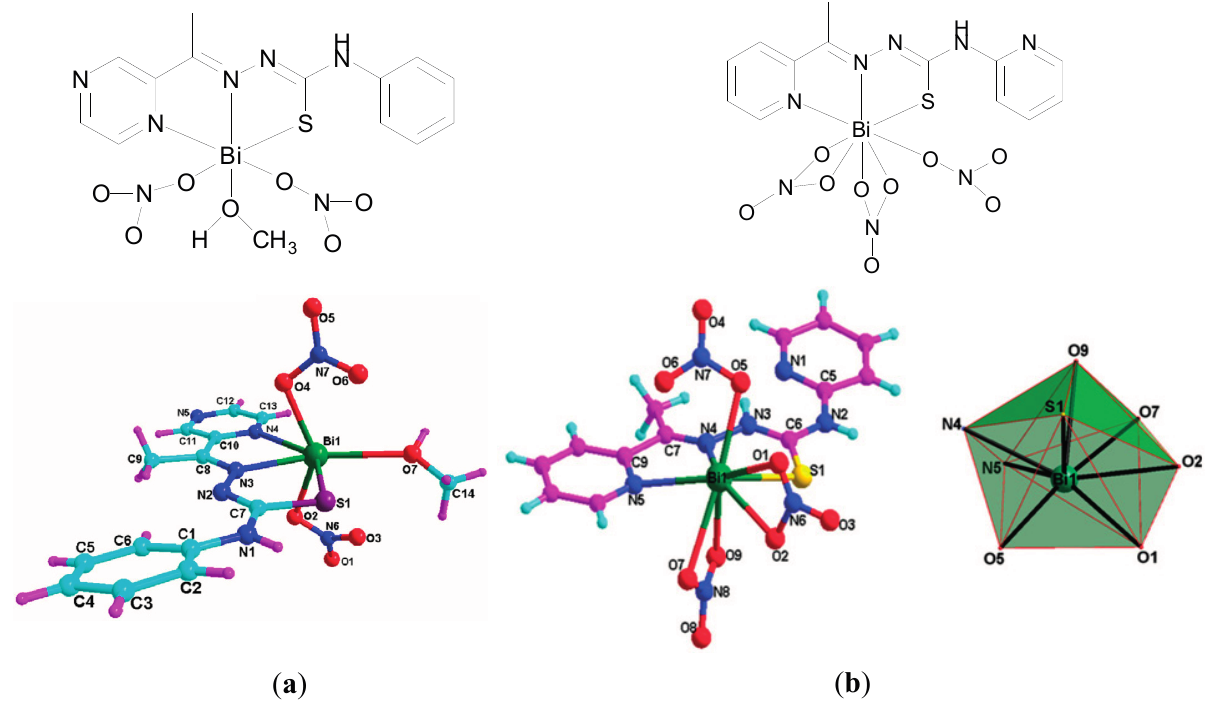
Figure 16. Molecular structures of ( a ) a Bi(III) complex of 2-acetylpyrazine N (4)-phenylthiosemicarbazone (HL), [Bi(L)(NO 3 ) 2 (CH 3 OH)]. Reprinted with permission from [92]. Copyright (2012) Elsevier and ( b ) a Bi(III) complex of 2-acetylpyridine, N (4)-pyridyl thiosemicarbazone (HL), [Bi(HL)(NO 3 ) 3 ] and polyhedron showing dodecahedral geometry around the bismuth atom of the asymmetric unit. Reproduced from [91] with permission from The Royal Society of